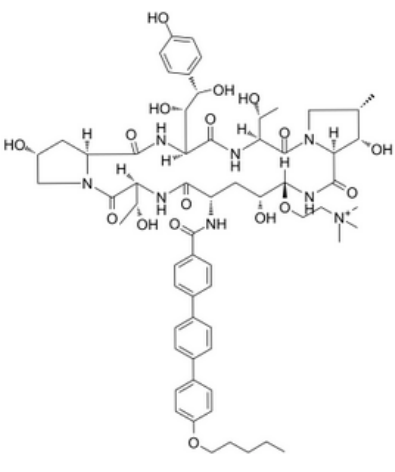
Figure 3. Chemical structure of rezafungin.